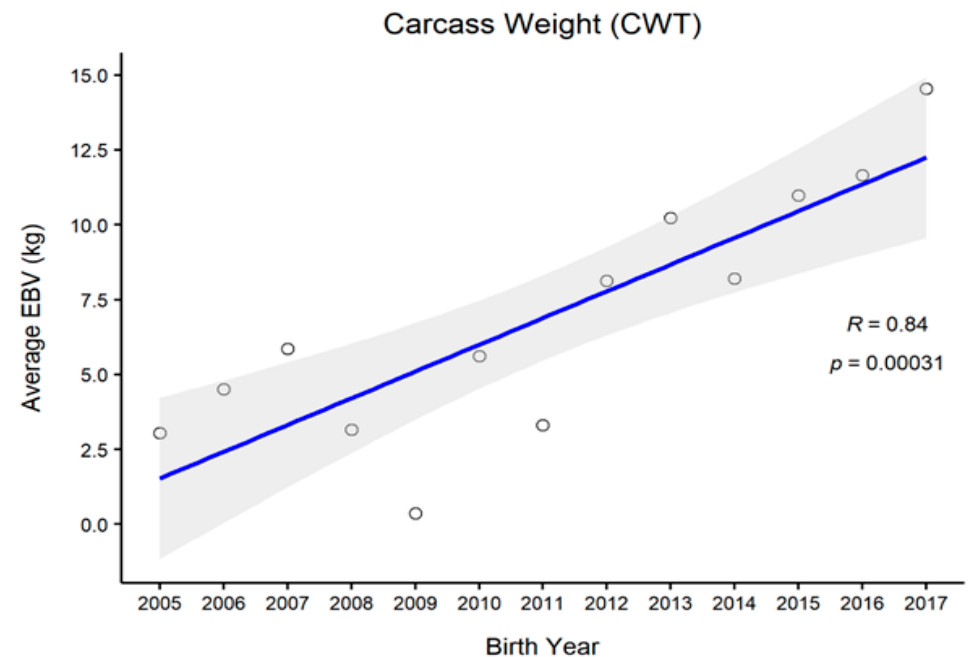
Figure 1. The genetic trend of estimated breeding values (EBVs) for the carcass weight of Hanwoo males from the 30-month production system (R, Pearson’s correlation coefficient; p , the p -value of correlation coefficients).